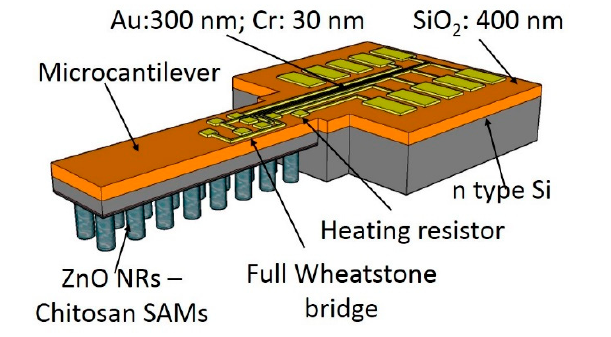
Figure 1. Schematic graph of a Si microcantilever with its back surface patterned with ZnO NRs/chitosan